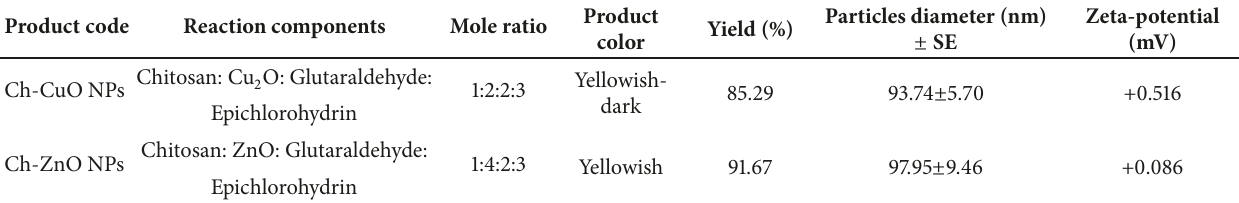
Table 1: Reaction conditions and characterizations of chitosan-metal oxide nanoparticles (Ch-MO NPs). Product